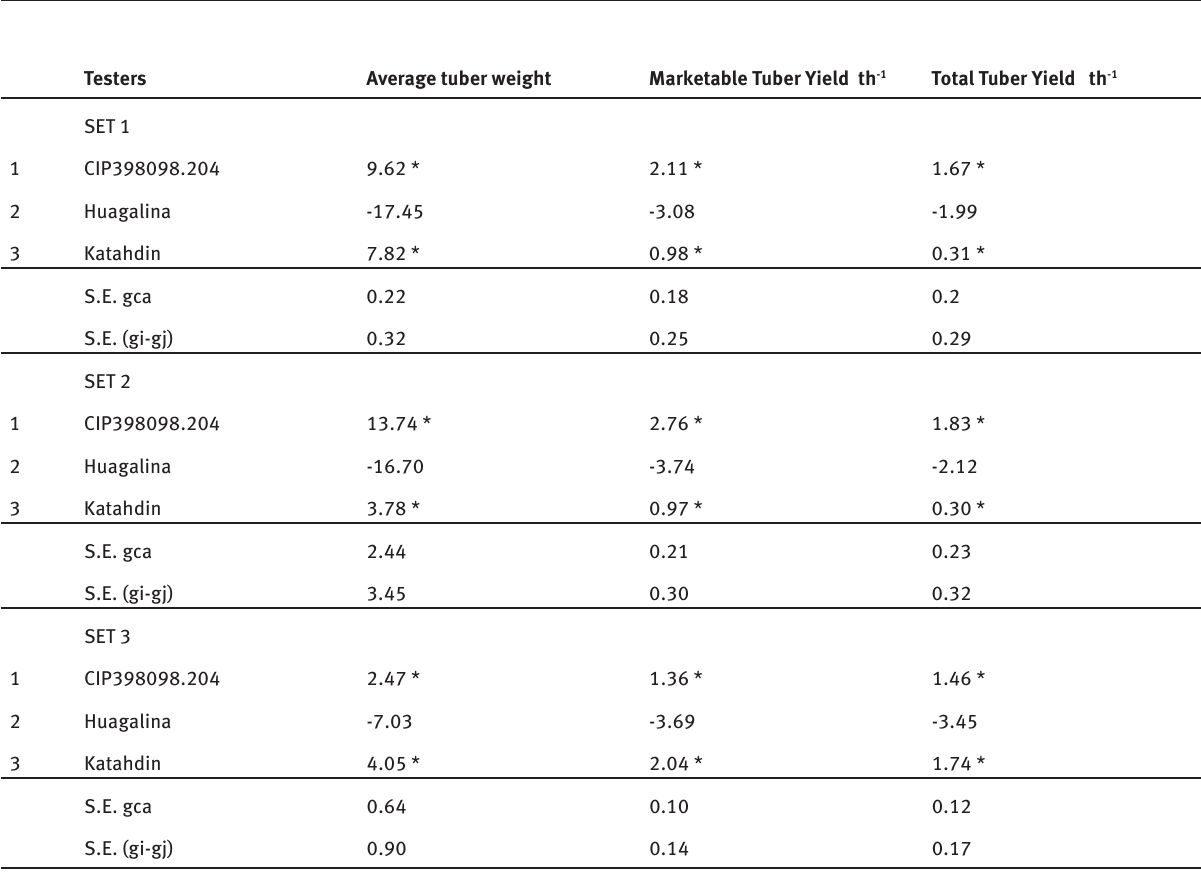
Table 7: Estimates of General Combining Ability (GCA) effects for testers, pooled over locations for average tuber weight, marketable and total tuber yield, in three sets of clones from LBHT